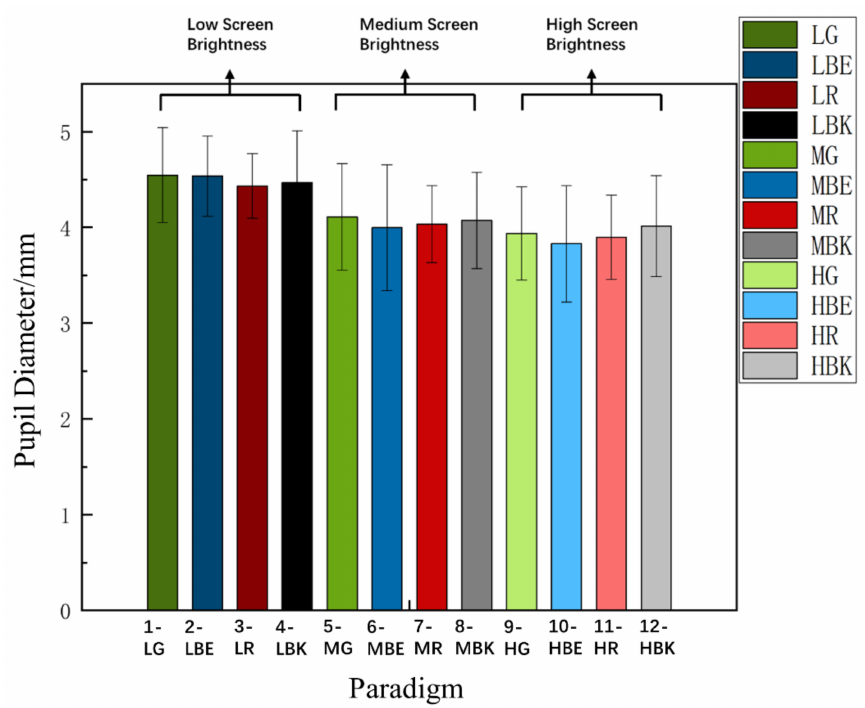
Figure 4. Comparison of the mean values and SD of pupil diameter for 12 paradigms over 15 subjects. Statistics were assessed by one-way repeated-measures ANOVA.